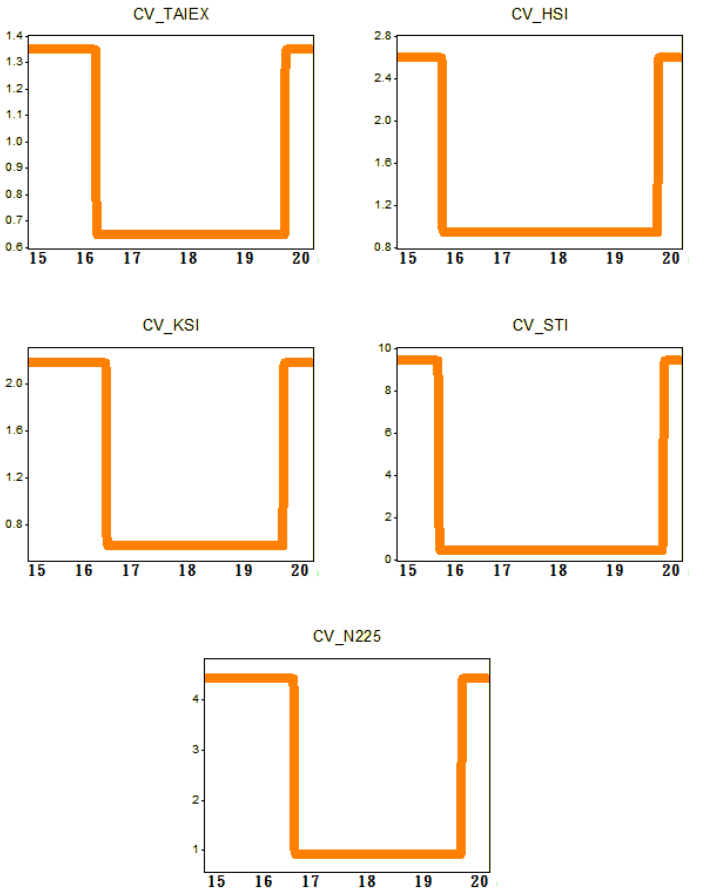
Figure 3: Estimation of unconditional variance under ST-GARCH model for stock market indices of the Four Asian Tigers and